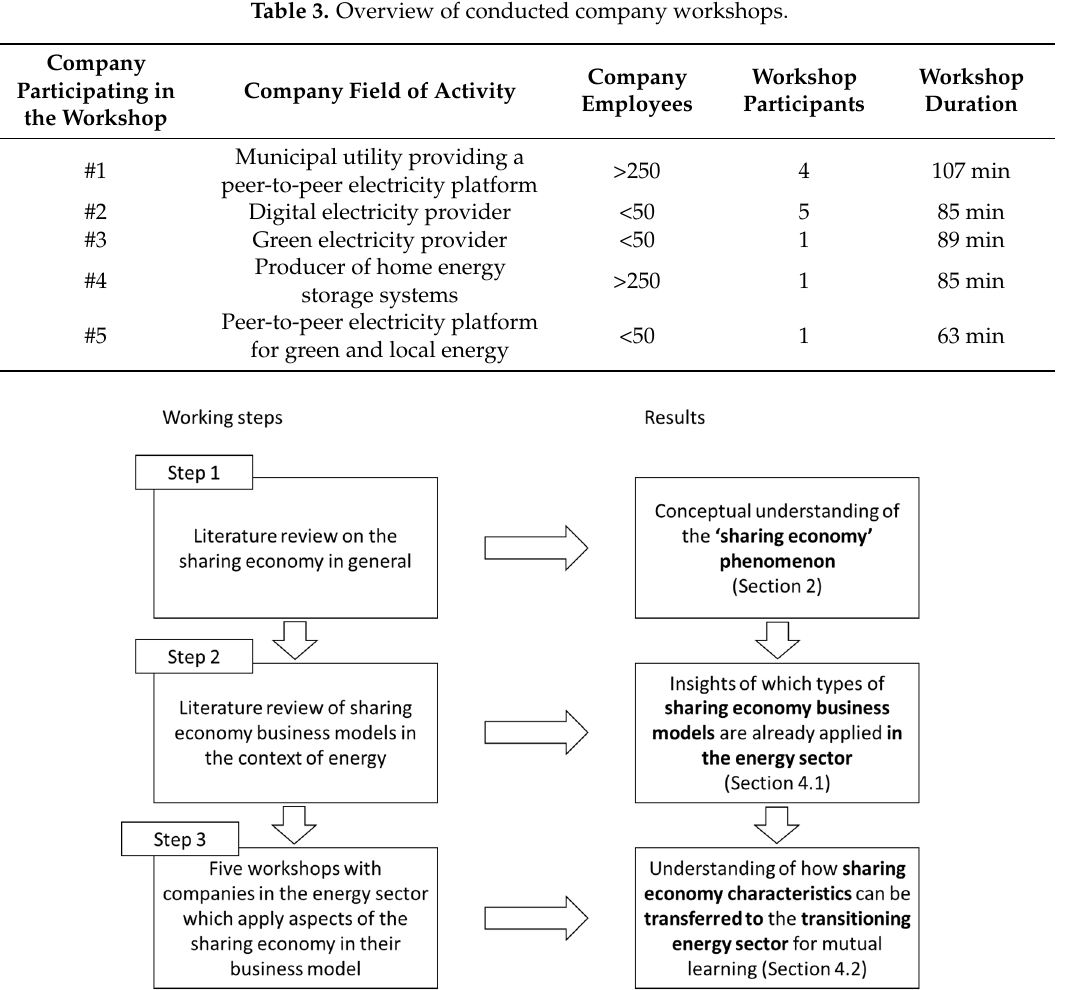
Figure 1. Steps of research process and associated results (own illustration).